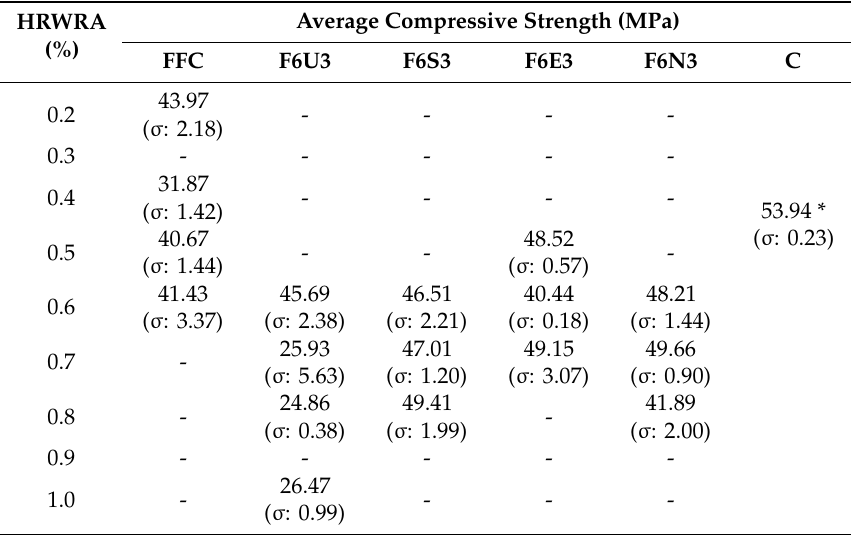
Table 5. Average 28-day compressive strength ( σ = standard